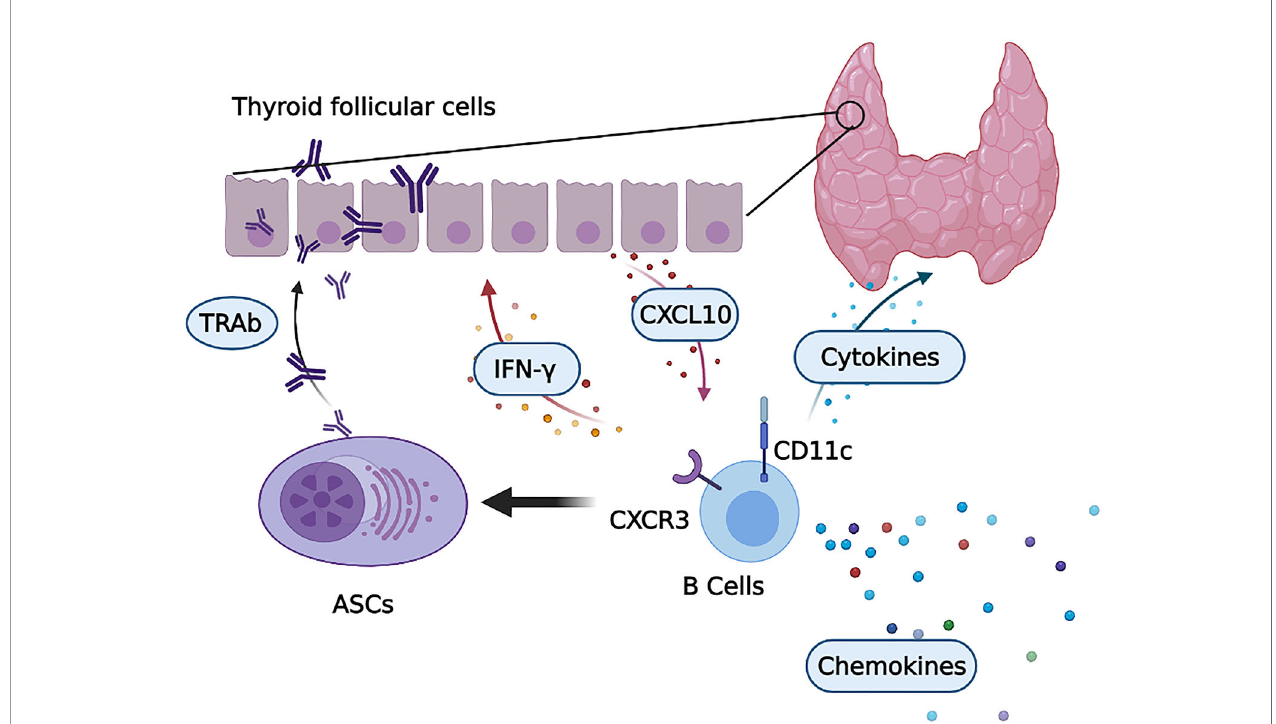
FIGURE 10 | CD11c + B cells in the thyroid are involved in the pathogenesis of GD. In fi ltrated CD11c + B cells with high CXCR3 expression were induced to differentiate into autoreactive antibody-secreting cells (ASCs) that secrete thyroid autoantibodies, including TRAbs. Activated CD11c + B cells secrete a variety of cytokines, such as IFN- g , to exacerbate local thyroid in fl ammation. This process induced thyroid follicular cells (TFCs) to secrete CXCL10, which recruited CXCR3- expressing lymphocytes, including CD11c + B cells. Then, CD11c + B cells and TFCs formed a positive in fl ammatory feedback loop. In addition, a number of chemokines were secreted by CD11c + B cells, which potentiated lymphocyte in fi ltration into the thyroid of GD